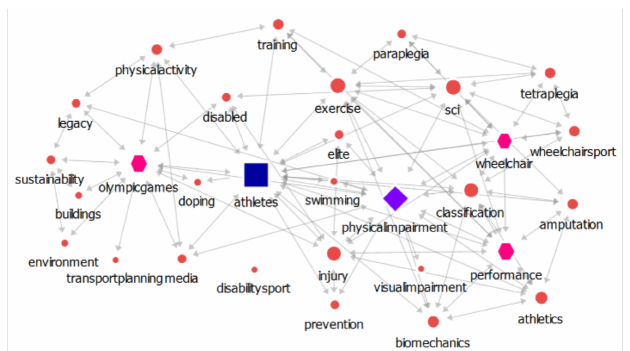
Figure 5. KNA chart of Paralympic studies in Section 1.